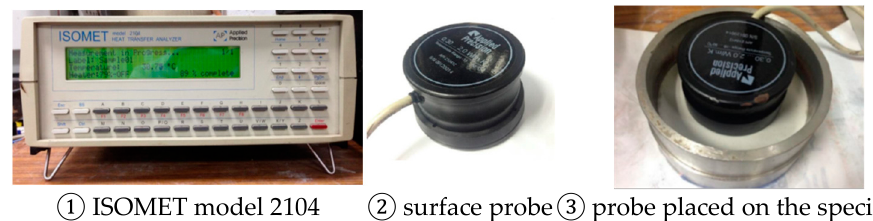
Figure 6. ISOMET-based experimental system for the TPS method.